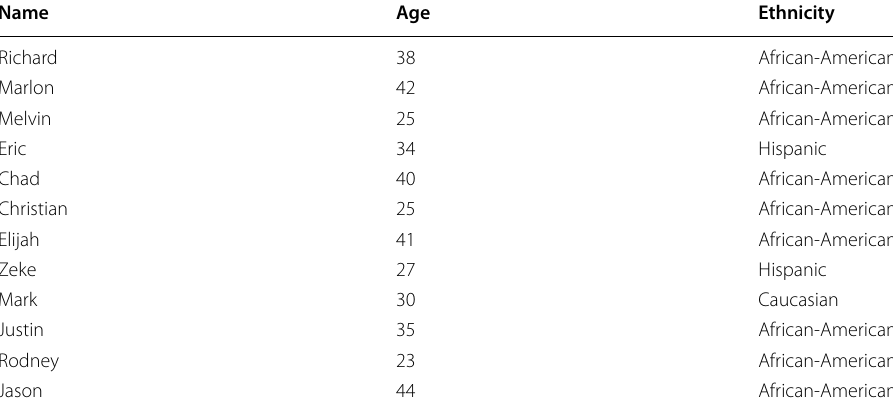
Table 1 Name, age, and